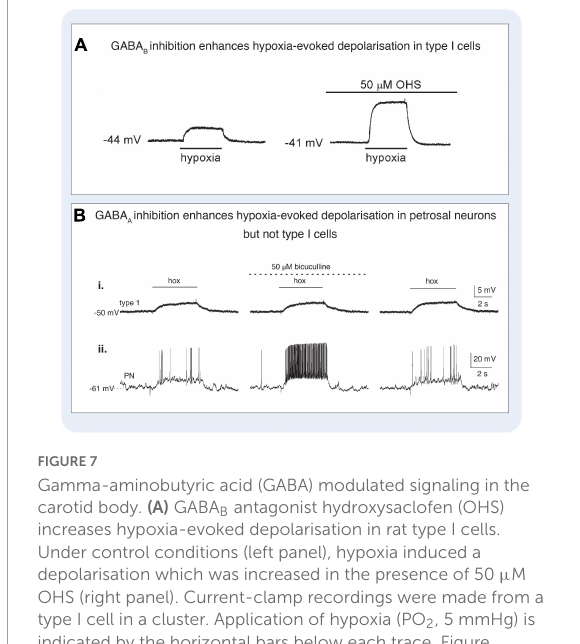
FIGURE7 Gamma-aminobutyric acid (GABA) modulated signaling in the carotid body. (A) GABA B antagonist hydroxysaclofen (OHS) increases hypoxia-evoked depolarisation in rat type I cells. Under control conditions (left panel), hypoxia induced a depolarisation which was increased in the presence of 50 µ M OHS (right panel). Current-clamp recordings were made from a type I cell in a cluster. Application of hypoxia (PO 2 , 5 mmHg) is indicated by the horizontal bars below each trace. Figure reproduced with permission from Fearon et al. (2003). (B) GABA A antagonist bicuculline increases hypoxia-evoked depolarisation in rat petrosal neurons but not type I cells. Simultaneous gramicidin perforated-patch recordings were obtained from a type I cell (that was part of a cluster, and an adjacent petrosal neuron (PN). Depolarizing responses to hypoxia (hox; PO 2 , 5 mmHg) were recorded in both the type I cell (i) and the functional PN (ii), where suprathreshold responses were evoked. In the presence of the 50 µ M bicuculline, there was a marked potentiation of the PN response resulting in a robust increase in spike discharge (ii, middle trace), whereas the type I cell response was unaltered (i, middle trace). Reversibility of these responses following wash-out of the drug is shown (right traces). Figure reproduced with permission from Zhang et al.